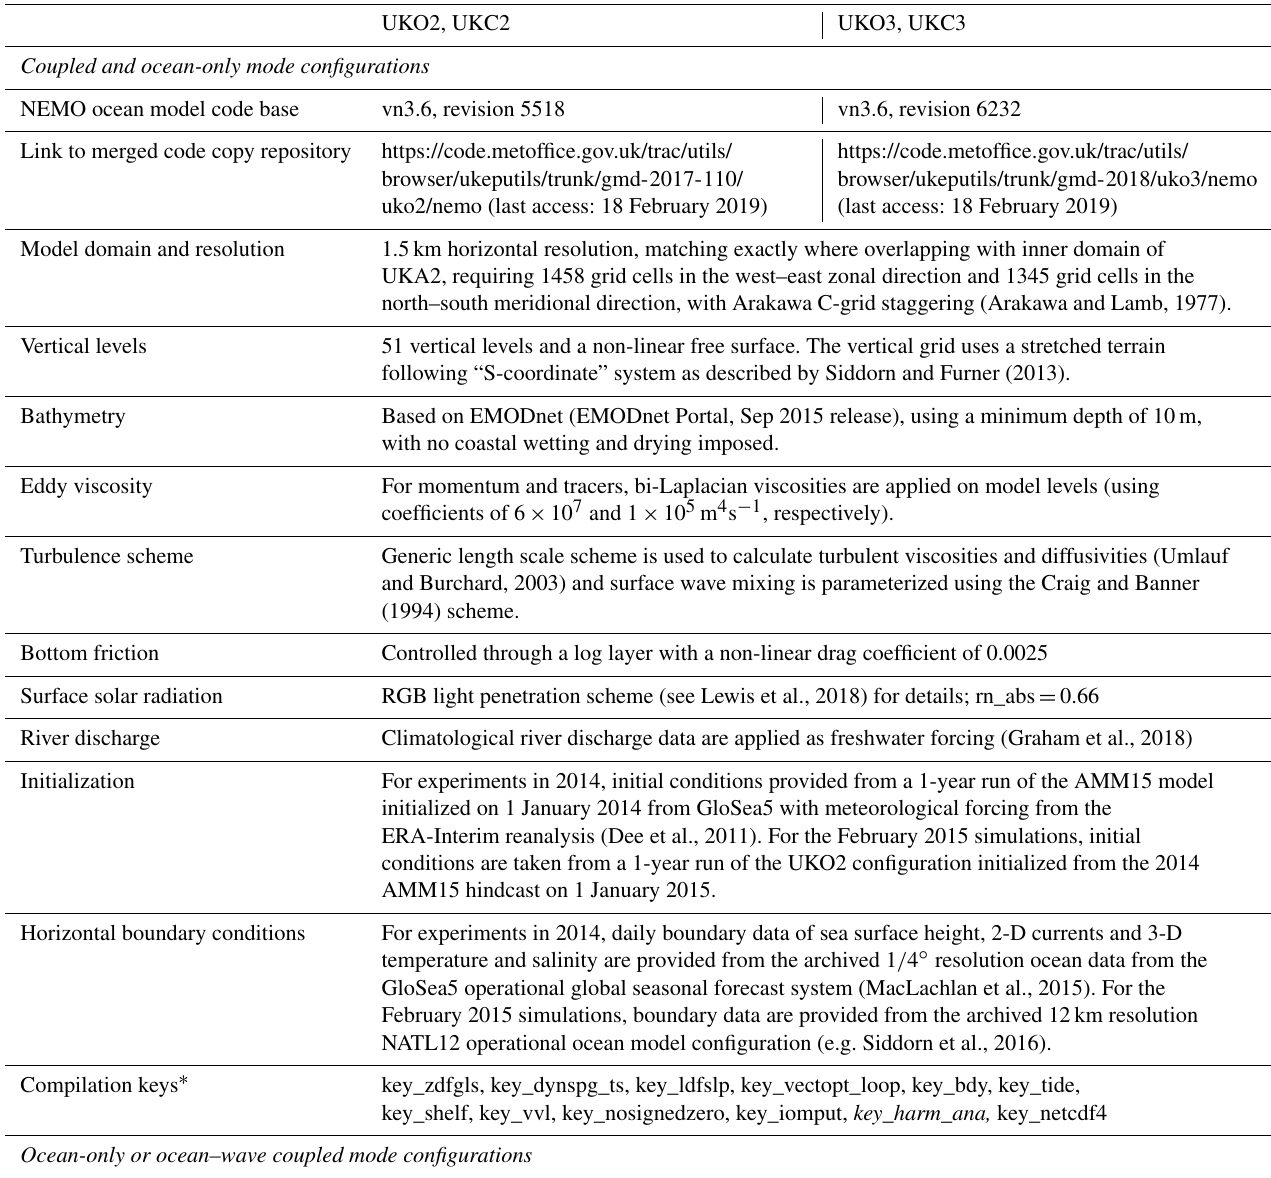
Table 8. Summary of UKO3 ocean component, and key similarities and differences to the UKO2 configuration described by Lewis et al. (2018). Note that the NEMO compilation key key_harm_ana was only used in UKO3